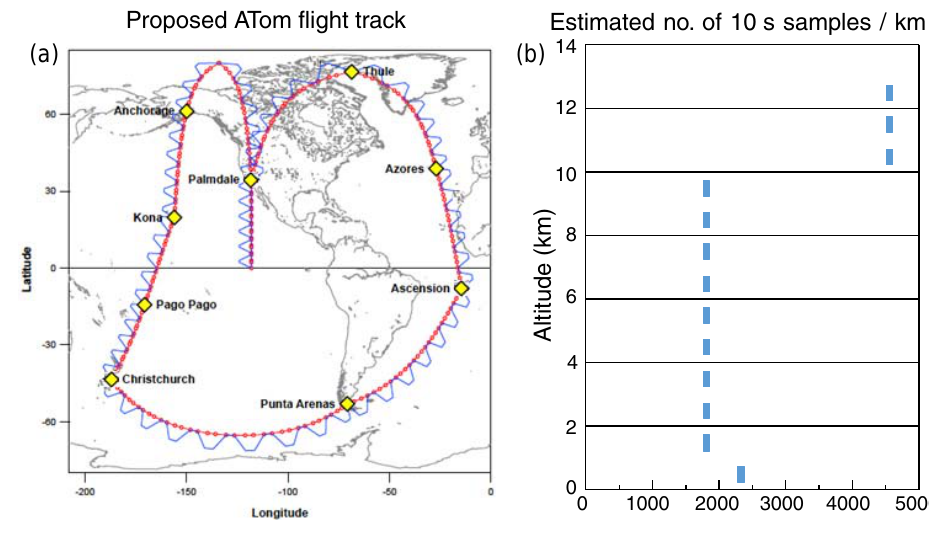
Figure 9. ATom proposed flight tracks (a) and estimated sampling frequency by 1km altitude bins (b) . The actual flights are somewhat altered. The altitude sampling is based on the proposed ∼ 90h of flight time, ∼ 180 profiles taking ∼ 35min for each pair of climb-descend, and 5min spent each profile in the marine boundary layer. For up-to-date information on the ATom mission and deployments, see https: